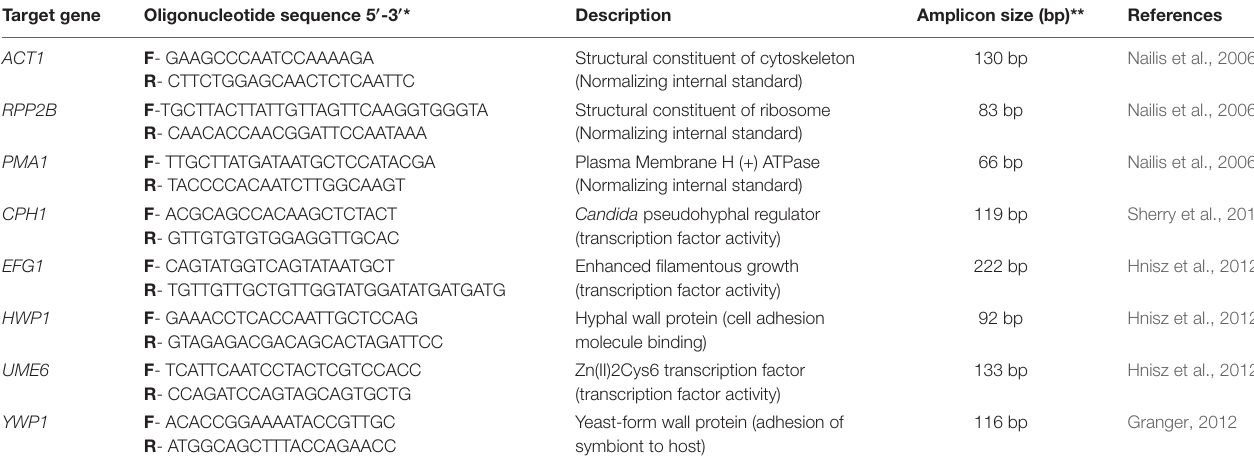
TABLE 1 | Quantitative real-time PCR